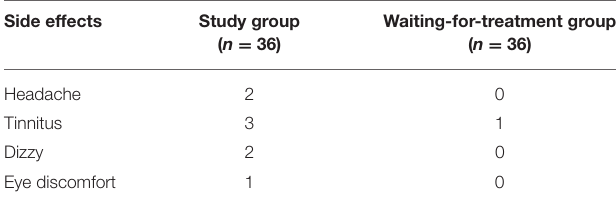
TABLE 5 | Side effects during rTMS